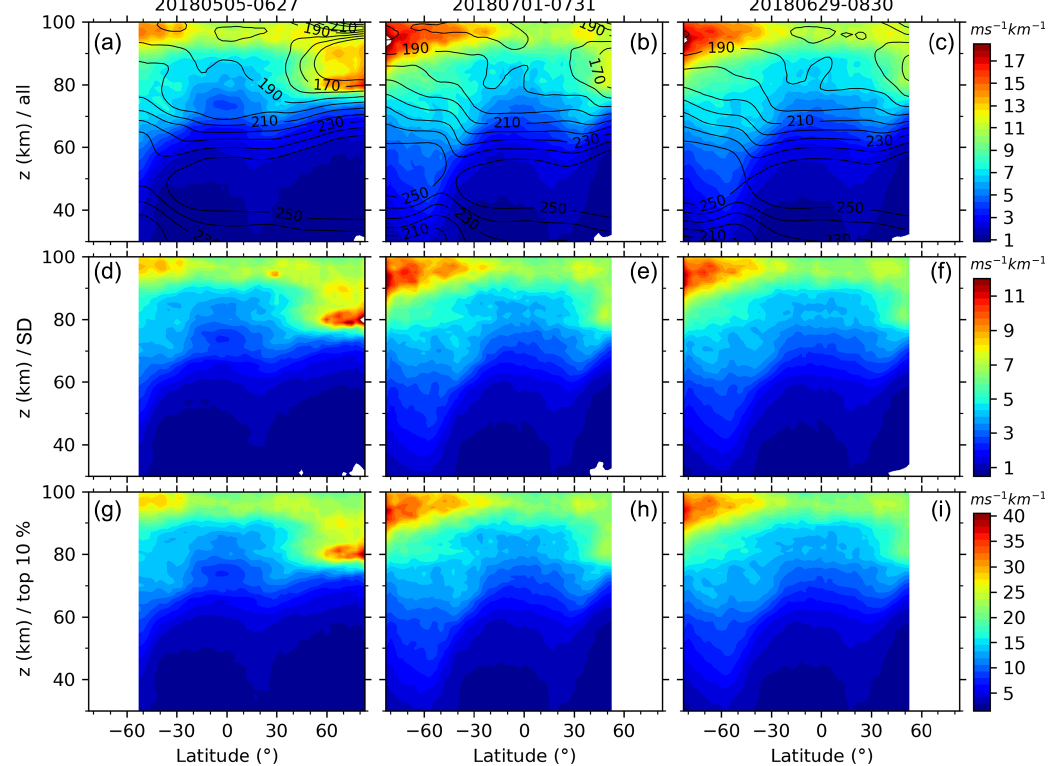
Figure 4. Latitude–height contours of the zonal means (a, b, c) and standard deviations (SD, d, e, f ) of GW-perturbed shears and the top 10% largest shears (bottom row) during three periods ( a, d, g , 0506–0627; b, e, h , 0701–0731; c, f, i , 0629–0830; the four numbers mean month and day). The contour lines shown in (a) , (b) , and (c) are the corresponding zonal-mean temperature. Same color scale is used in each row with units of ms − 1 km − 1 . All panels have the same scales for both the x axis and y axis.